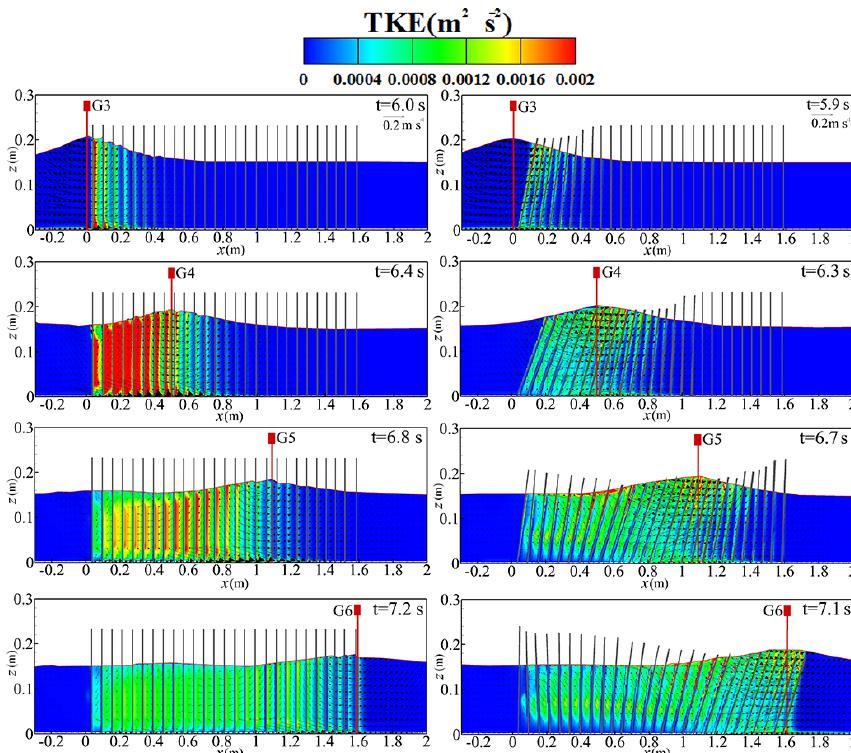
Figure 11. Snapshots of TKE for stationary cylinders (left) and moving cylinders (right), H i =